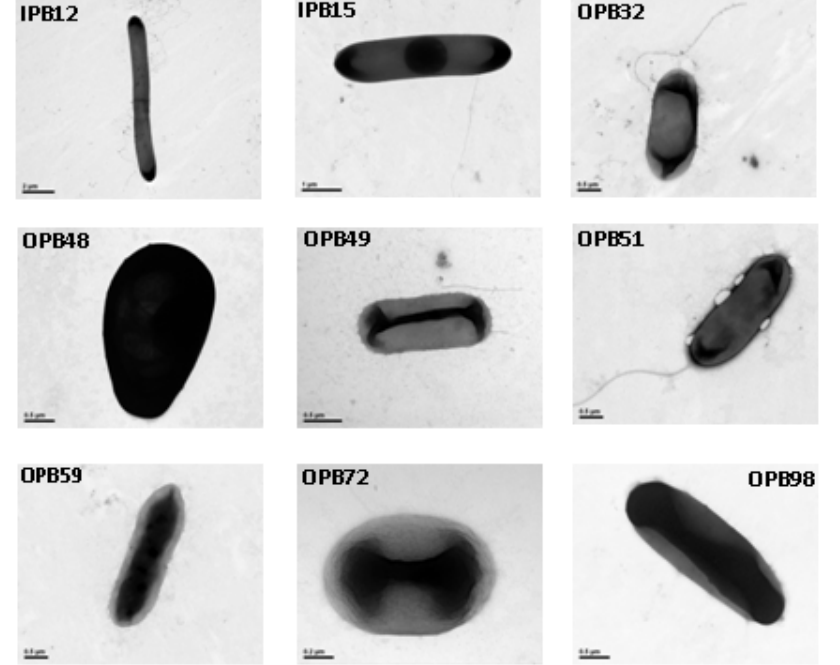
Figure 3. The morphological characterization of OPBs and IPBs under the transmission electron microscope (TEM).